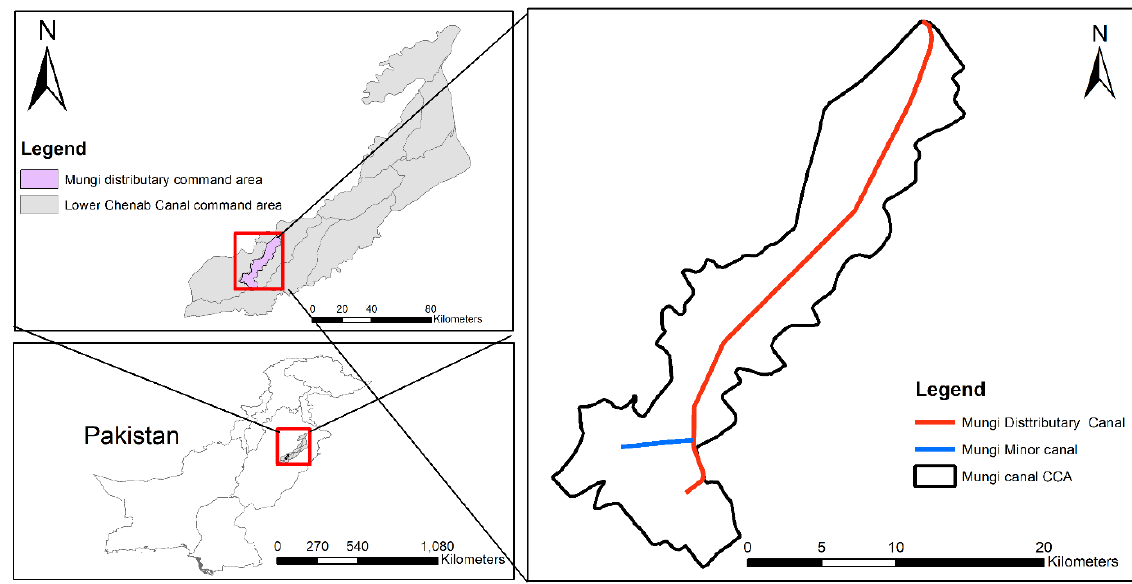
Figure 1. Position of the study region.